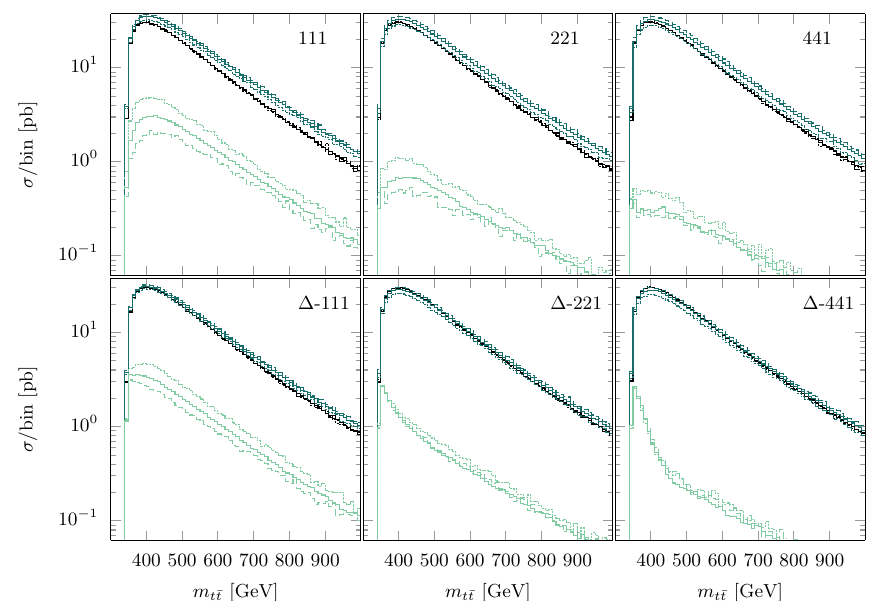
Figure 9 . As in (cid:12)gure 8, for S events rather than for H events.